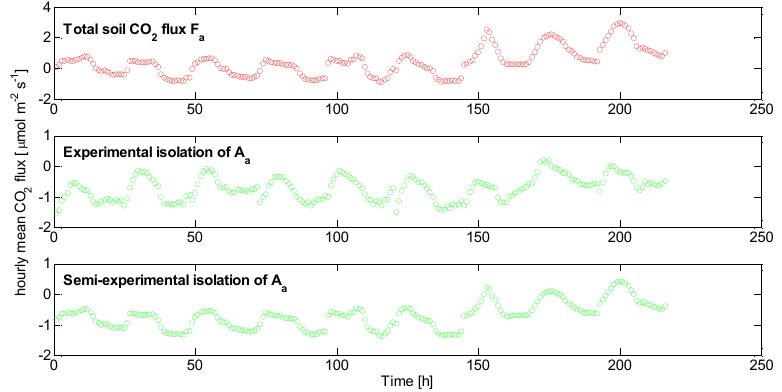
Figure 4. Isolated A a by experimental/semi ‐ experimental method.